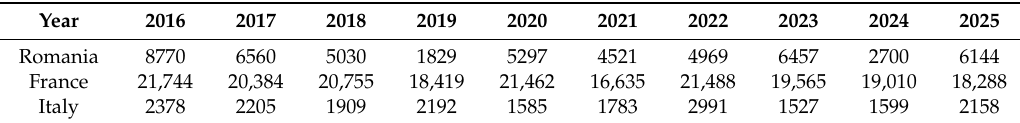
Table 7. Estimation of global bioethanol potential (million liters of absolute alcohol). Source: authors’ own calculation based on [56].